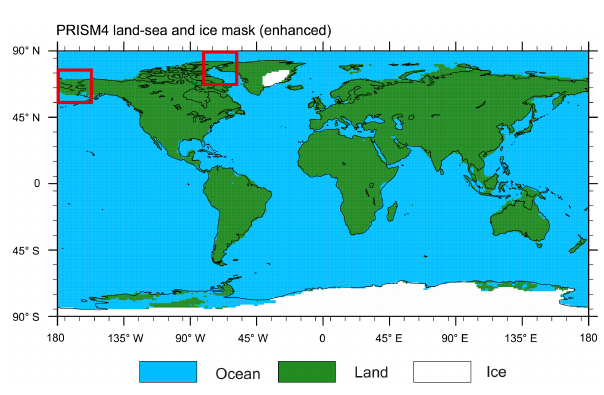
Figure 4. PRISM4 land–sea mask (enhanced version) show- ing Greenland and Antarctic ice sheet distribution. Canadian archipelago and Bering Strait closed (red boxes) in both the stan- dard and enhanced boundary condition data